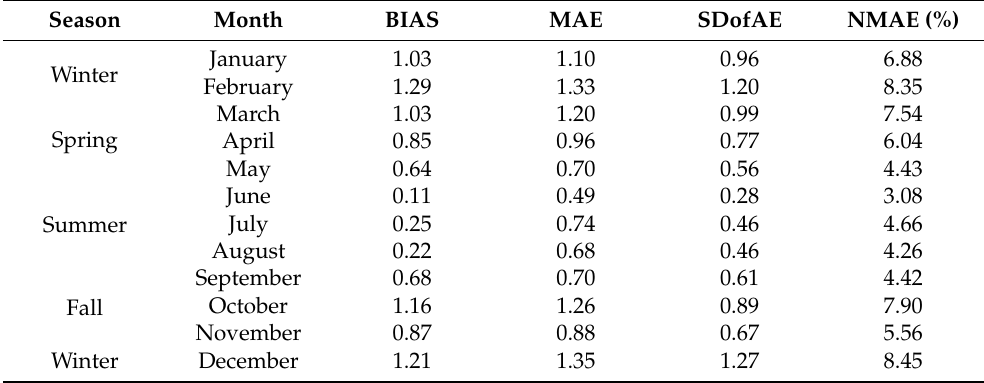
Table 3. Monthly error metric results for wind power output